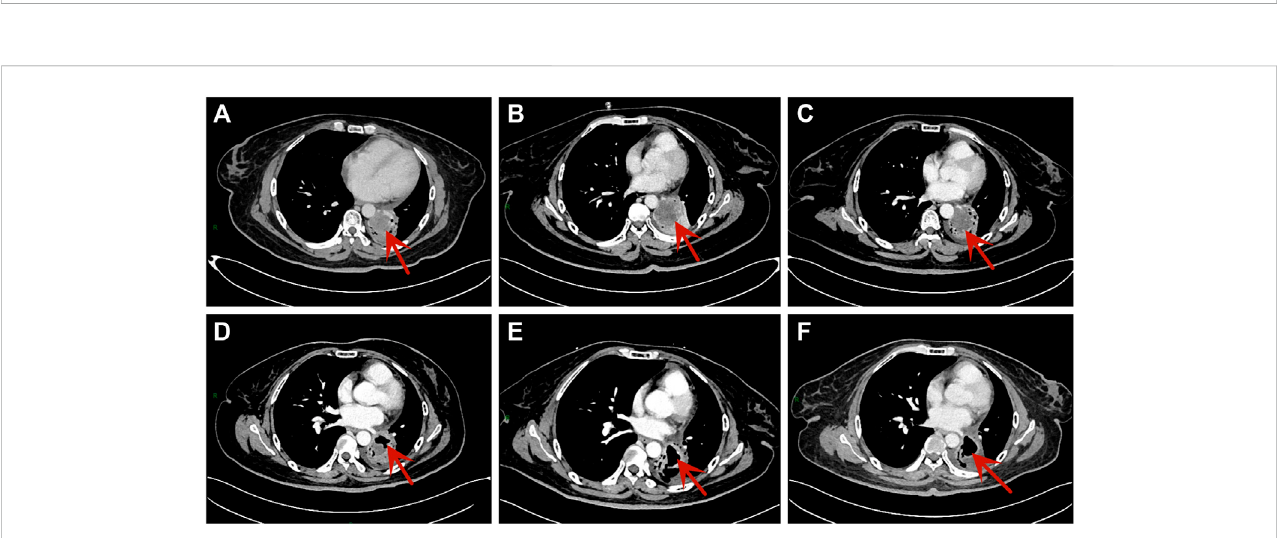
FIGURE 2 Chest CT scans of the patient. (A) The scan was performed after second-line treatment. (B) The scan was performed after third-line treatment. (C) The scan was performed after taking anlotinib for one cycle. (D) The scan showed tumor cavity formation after taking anlotinib for six cycles. (E) The scan showed tumor cavity was larger after taking anlotinib for eight cycles. (F) The tumor cavity didn ’ t change signi fi cantly after taking anlotinib for 10